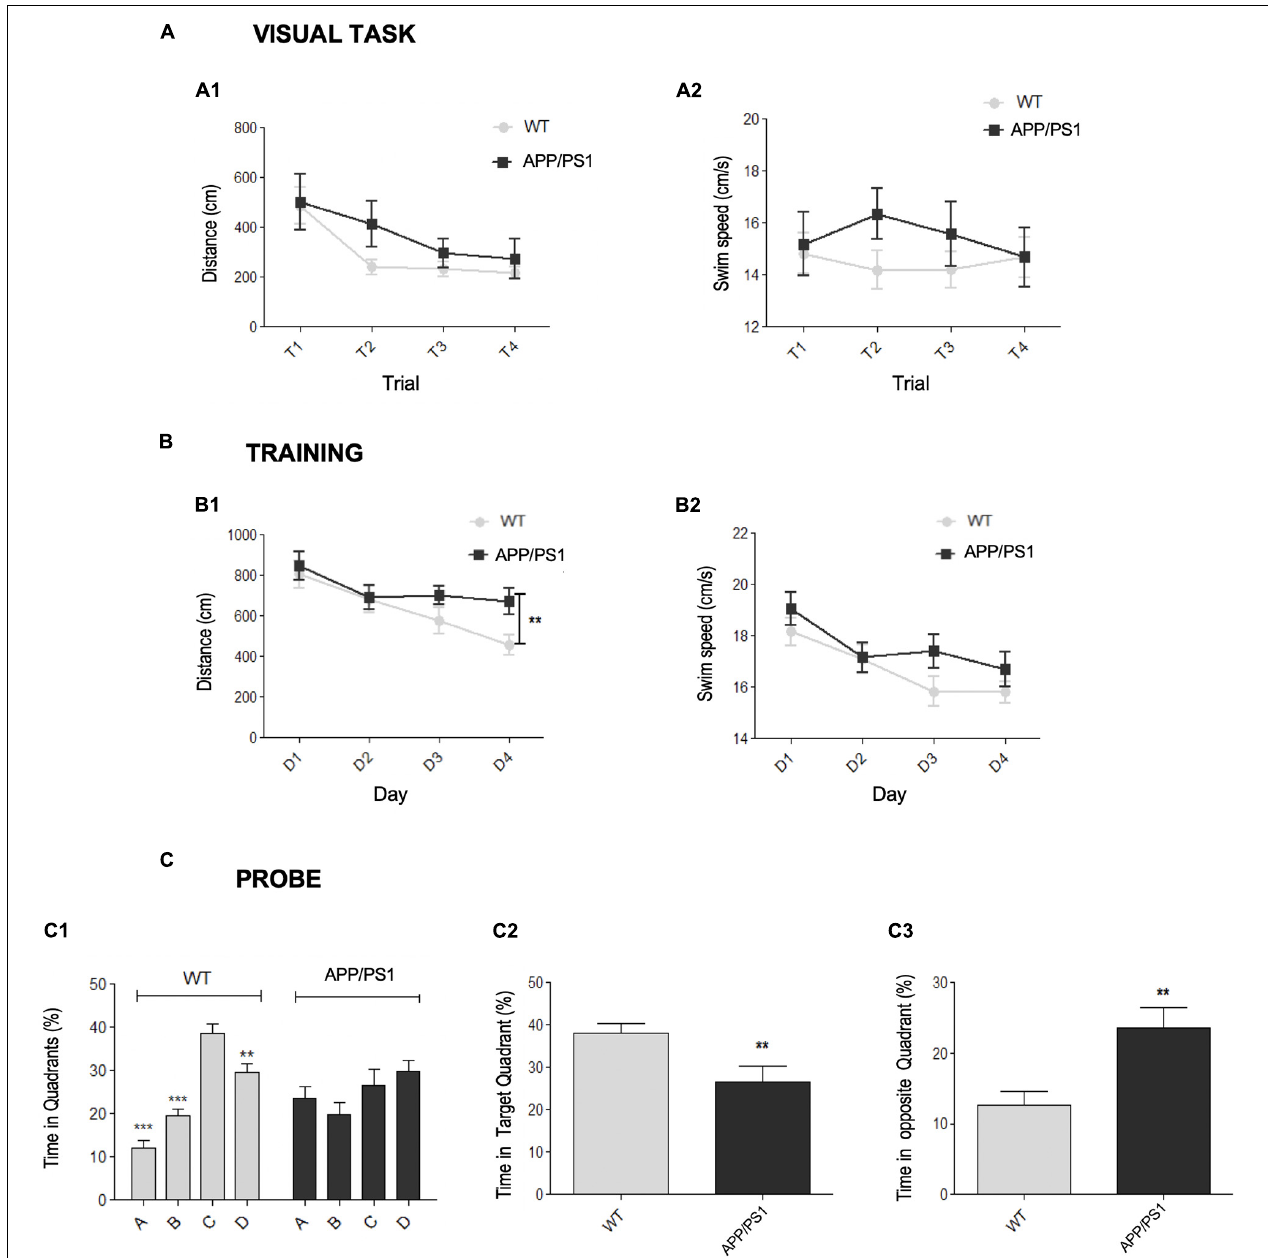
FIGURE 1 | Early spatial memory deficits in APP/PS1 model. (A–C) Morris Water Maze (MWM) test for APP/PS1 and WT 4.5-month-old mice. (A) Visual task. Two-way RM ANOVA analysis demonstrated that both genotypes correctly performed the visual task (escape latencies: [ F ( 1 , 123 ) = 0.26, p = 0.6152]; distance swum: [ F ( 1 , 123 ) = 1.74, p = 0.1946]). Differences in both latency [ F ( 1 , 123 ) = 7.06, p = 0.0002] and distance traveled [ A1 , F ( 3 , 123 ) = 7.06, p = 0.0002] were found across the trials, demonstrating the improvement along the task-course. No significant interaction effect was found on either latency [ F ( 3 , 123 ) = 1.68, p = 0.1752]